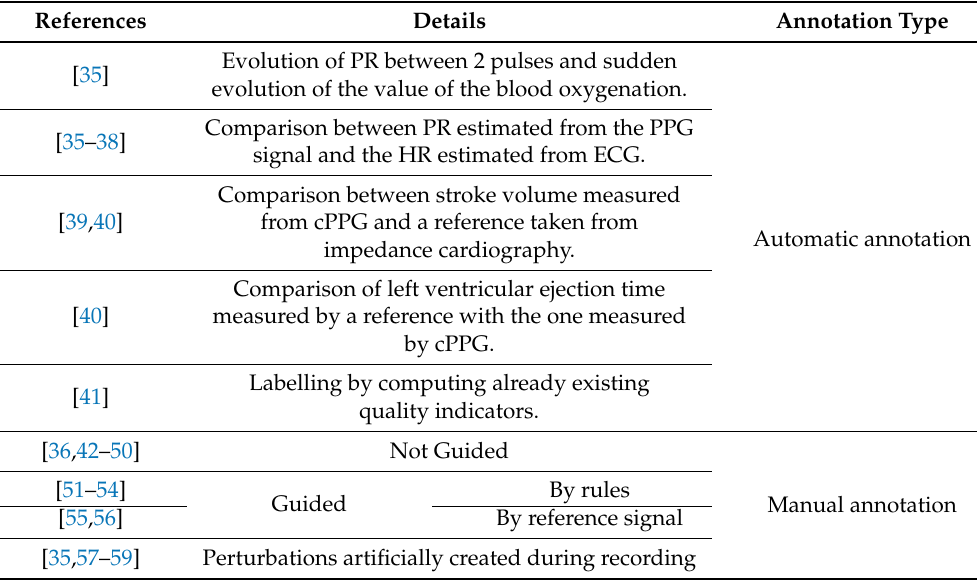
Table 3. Classification of papers addressing SQI according to the annotation